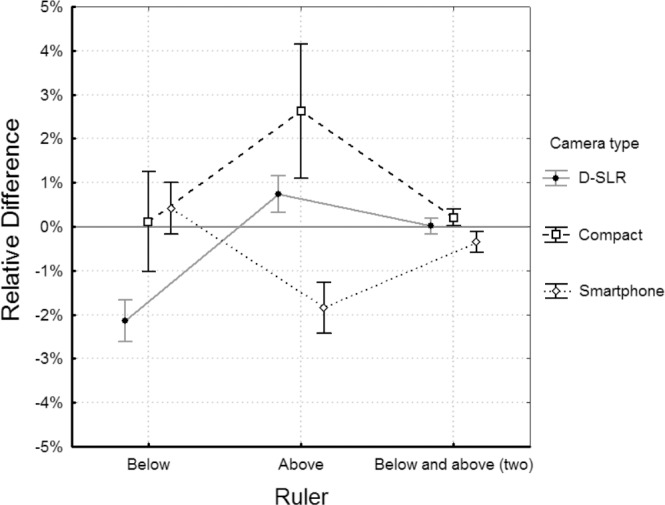
Relative differences between the measured area and reference area expressed in percentage for the digital planimetry based on photographs taken by 3 types of digital cameras in 3 positions of ruler: below the wound shape, above the wound shape, and with 2 rulers placed below and above.Vertical bars denote 95% confidence intervals.